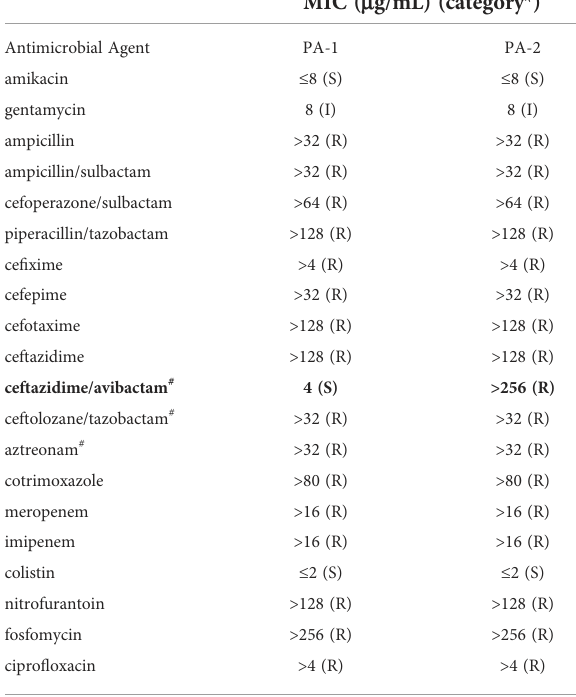
TABLE 1 Antimicrobial susceptibility pro fi le of P. aeruginosa